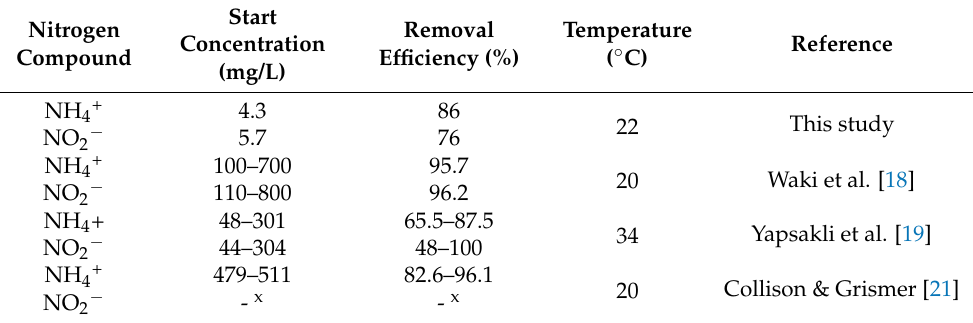
Table 5. Influent NH 4+ and NO 2 − nutrient concentrations used and nitrogen removal efficiencies in comparison studies.